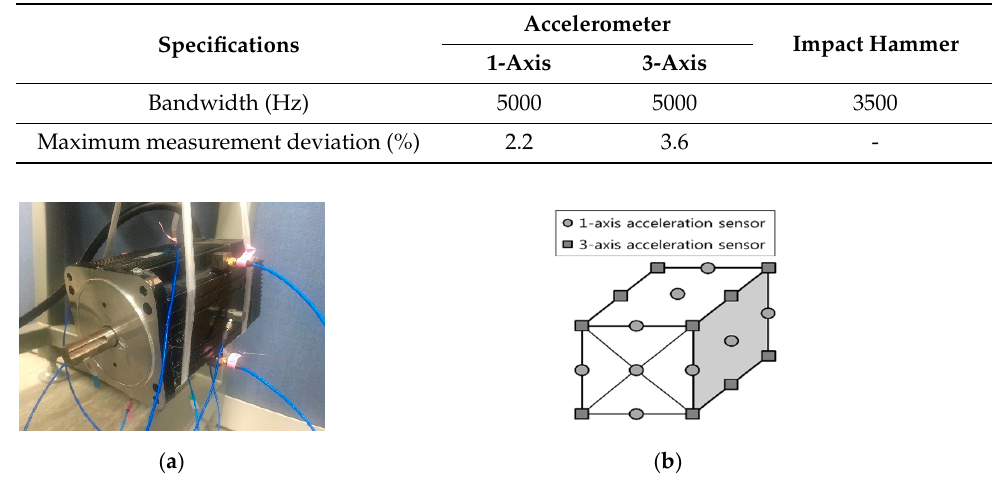
Figure 4. Equipment for the impact hammer test: ( a ) digital acquisition (DAQ) system and impact hammer; ( b ) single-axial (left), and tri-axial (right) accelerometer. Table 2. Specifications of the equipment.